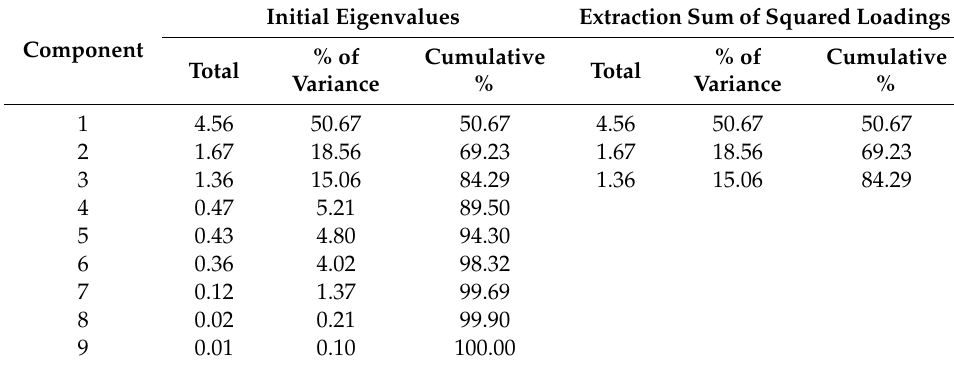
Table 3. Initial eigenvalues and extracted